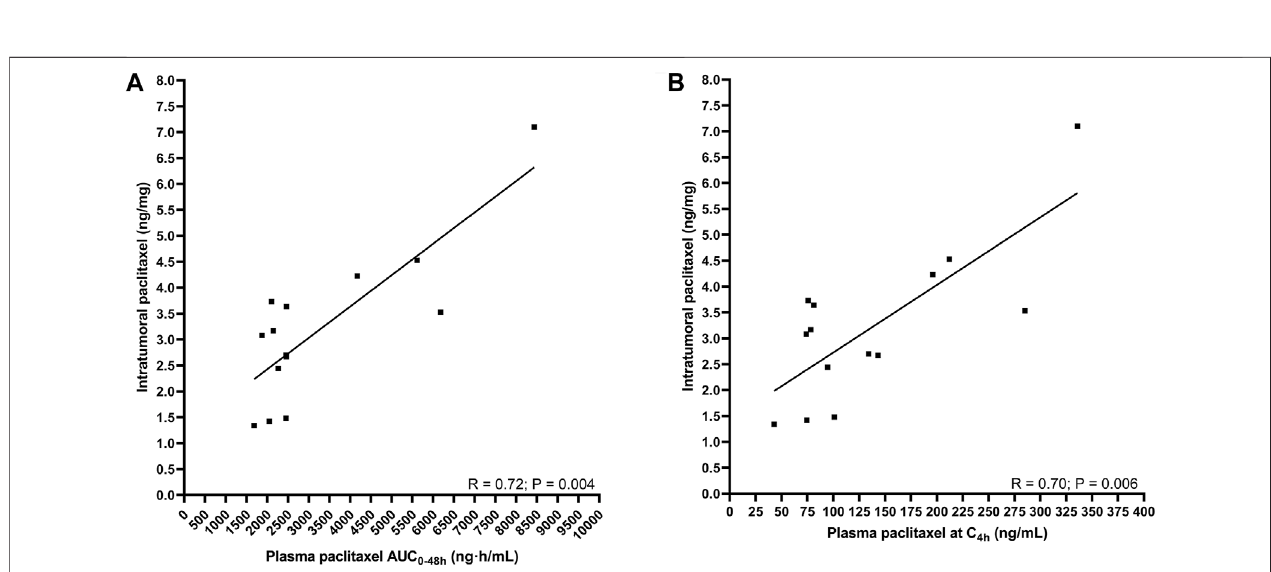
FIGURE 2 | The correlation between intratumoral pharmacokinetics and plasma pharmacokinetics of paclitaxel. (A) intratumoral paclitaxel concentration and AUC 0 – 48 h (B) intratumoral paclitaxel concentration and concentration at 4 h after start infusion.